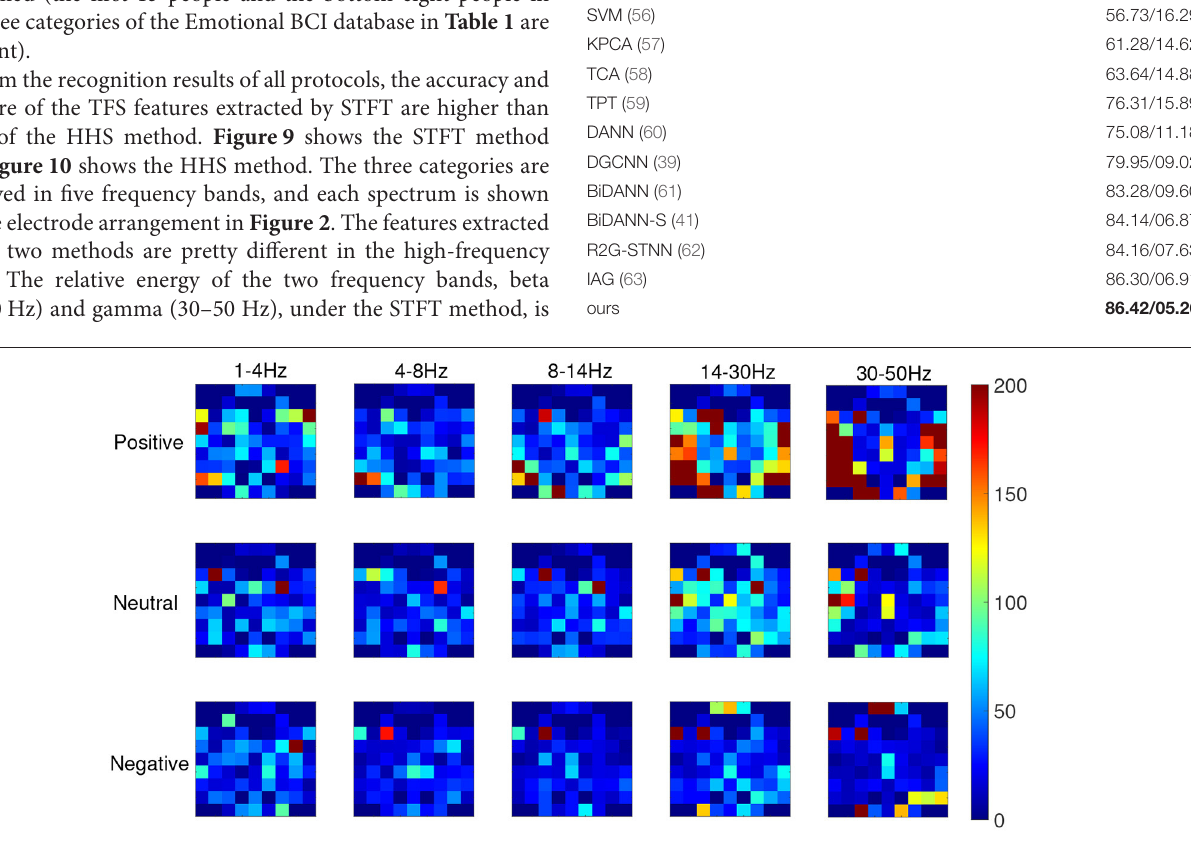
FIGURE 10 | The time-frequency spectrum (TFS) characteristic relative energy map (based on the HHS algorithm) corresponds to the electrode arrangement in Figure 2 .